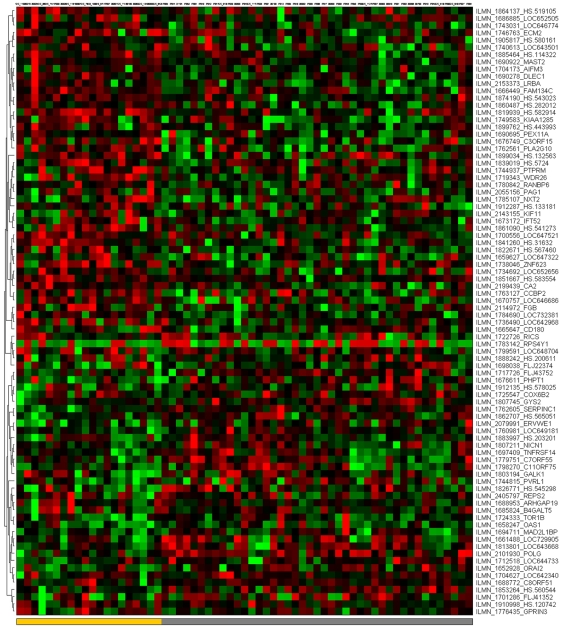
mRNA expression heatmap for the PP/SP signature.SPMS samples (yellow), PPMS (grey).